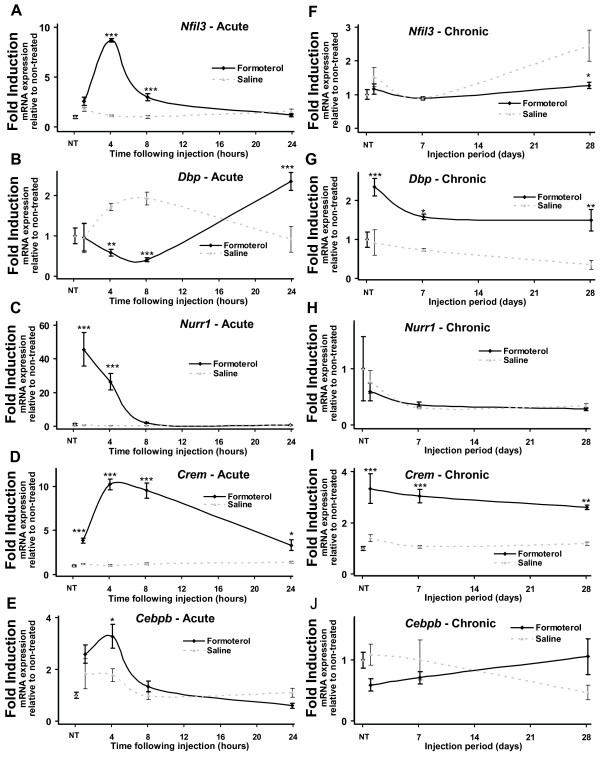
Acute and chronic systemic administration of formoterol alters the expression of genes associated with circadian rhythm and transcriptional regulation. Quantitative RT-PCR was used to assay the expression of A. Nfil3, B. Dbp, C. Nurr1, D. Creb, and E.Cebpb mRNAs in tibialis anterior over acute timepoints. Muscles were removed at 1, 4, 8 and 24 hours following a single intraperitoneal injection of formoterol or saline vehicle (NT = no treatment). For chronic timepoints, the expression of F. Nfil3, G. Dbp, H. Nurr1, I. Creb, and J.Cebpb mRNAs were measured in tibialis anterior removed at 1, 7 and 28 days following daily intraperitoneal injection of formoterol or saline vehicle (NT = no treatment). All results were normalized against 36B4 at each timepoint. Data are expressed as mean ± SEM (n = 5). Statistical significance was assessed using a one-way ANOVA with Bonferroni's post-test where p < 0.05 (*), p < 0.01 (**) and p < 0.001 (***). Unmarked data points are non-significant.